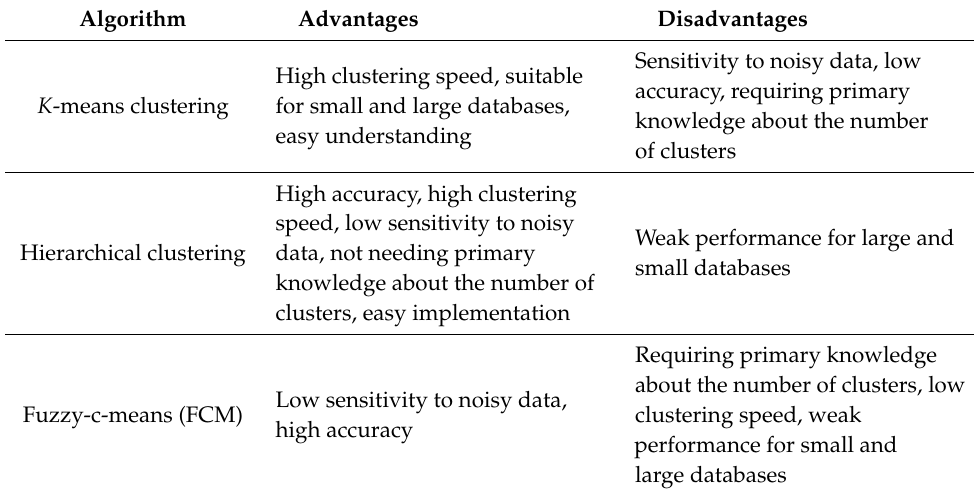
Table 5. Unsupervised learning methods and their advantages and